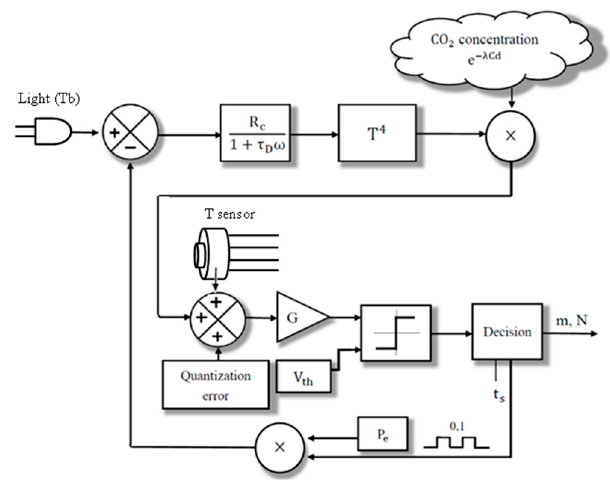
Figure 2. The Δ - Σ modulation architecture. Figure 2. The ∆ - Σ modulation architecture.